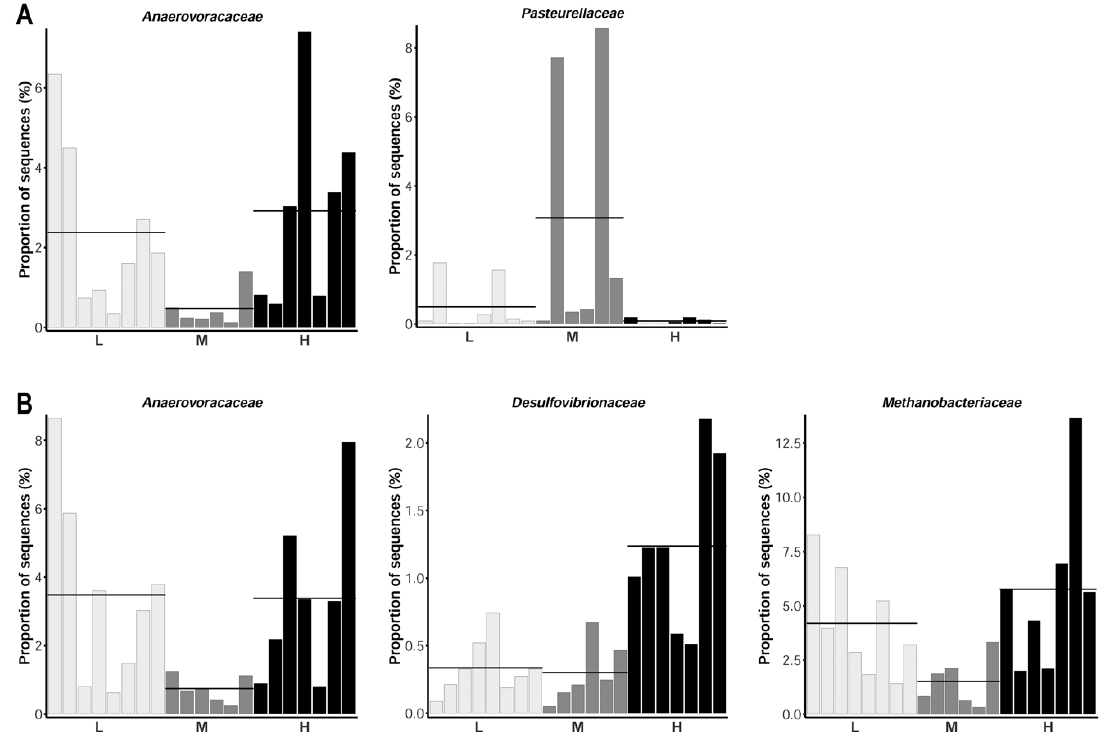
Figure 3. Significant differentially abundant taxa in ( A ) caecum and ( B ) colon digesta at family level (adjusted p < 0.05). Individual proportions of sequences assigned to the taxa are represented for each of the three dietary groups. L, M, H—dietary groups receiving lower, medium, and higher mineral P supplements.